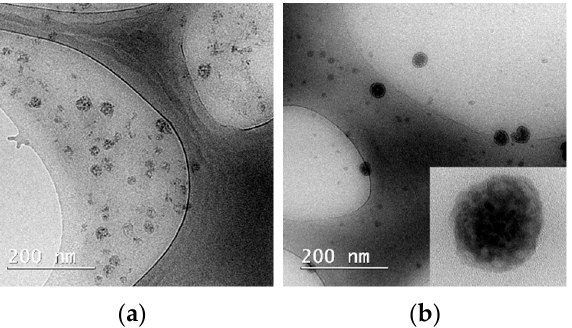
Figure 2. Representative TEM images of samples of void ( a ) and CURC-loaded P123 micelles ( b ).